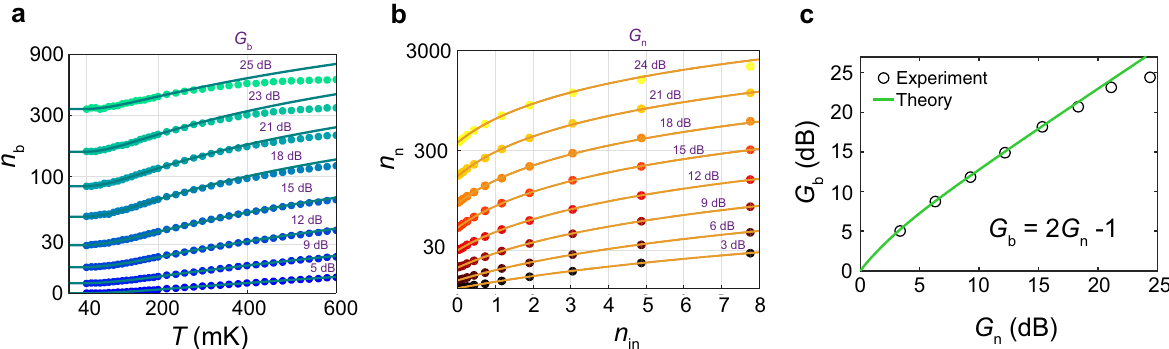
Fig. 3 Experimental determination of quantum ef fi ciency. a Planck spectroscopy for varying broadband gain G b . The average photon number n b of the ampli fi ed signal (dots) is indicated at the reconstruction point. The lines are fi ts to the corresponding Planck distributions. b Average photon number n n of the ampli fi ed signal (dots) at the reconstruction point for the ampli fi cation of a continuous coherent signal for different values of the narrowband gain G n . The average photon number of the input signal is labeled with n in . From the offsets of the linear fi ts (lines), we can calculate the number of added noise photons. c Experimentally determined broadband gain G b vs. narrowband gain G n of the